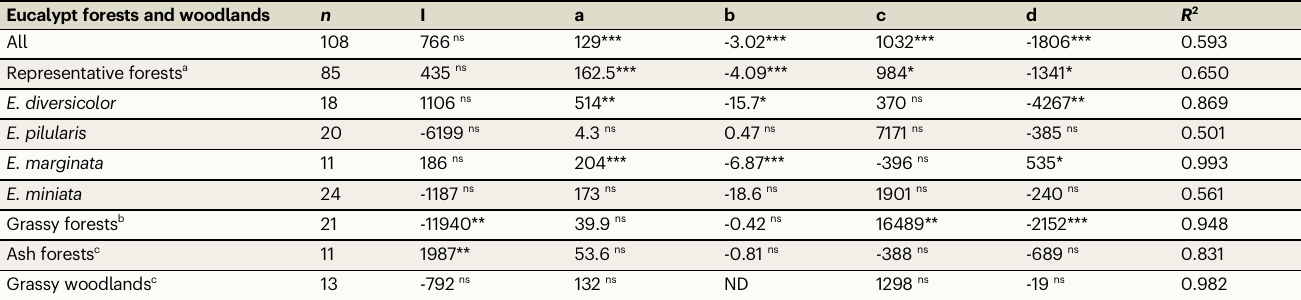
Table 2 | Best- fi t (modi fi ed quadratic) models (all P < 0.001, F-statistic) for accumulation of litter mixtures (leaves, twigs, bark; X Tsf ) in eucalypt forests and woodlands